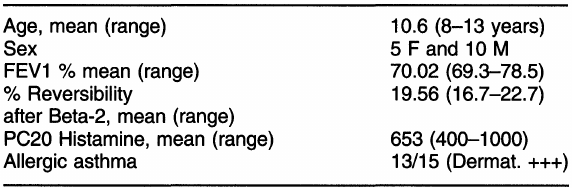
Table 4. Clinical features of children recruited for the trial in treat- ment group 2*